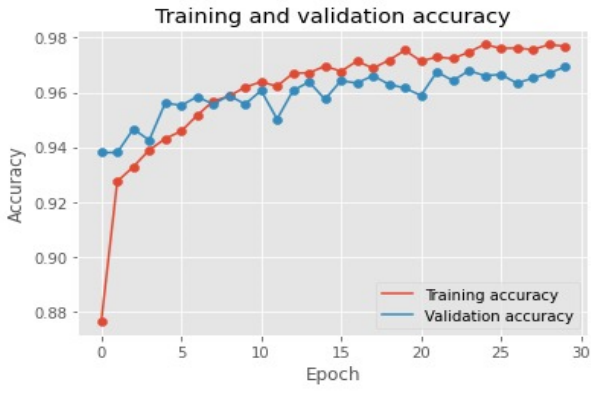
Figure 3. Visualization training and validation accuracy of APNA .